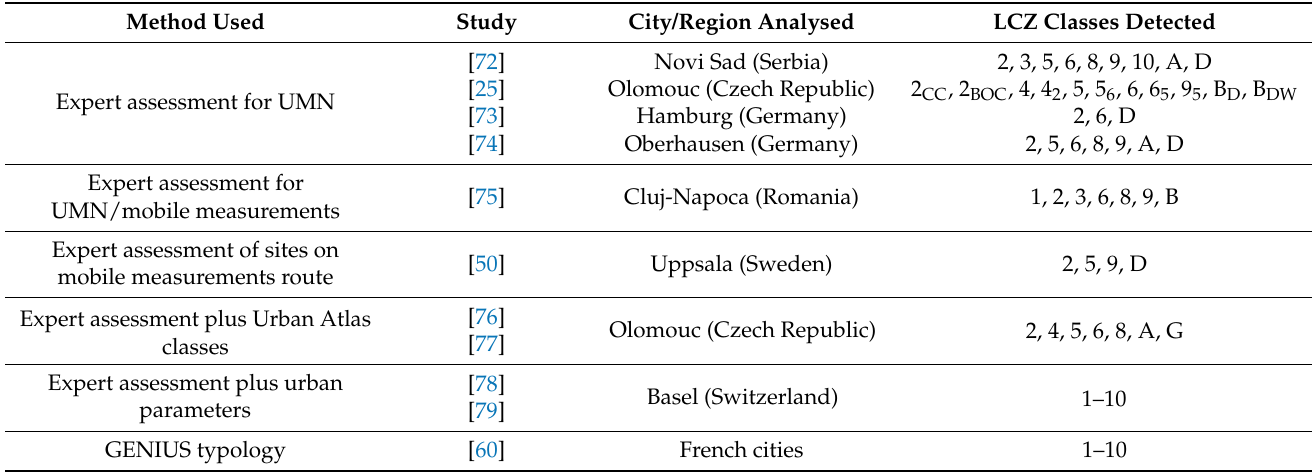
Table 1. Expert knowledge-based methods for mapping LCZs, as derived for the purposes of review. Method